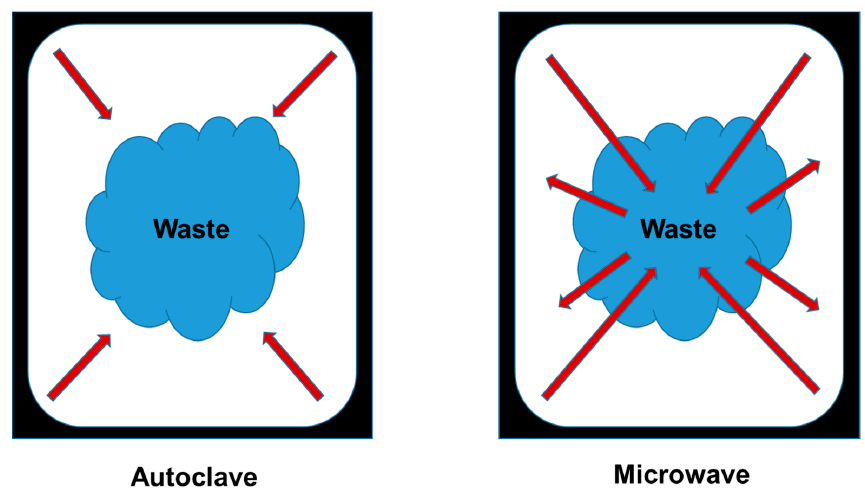
Figure 2. Heat generation in microwaves.